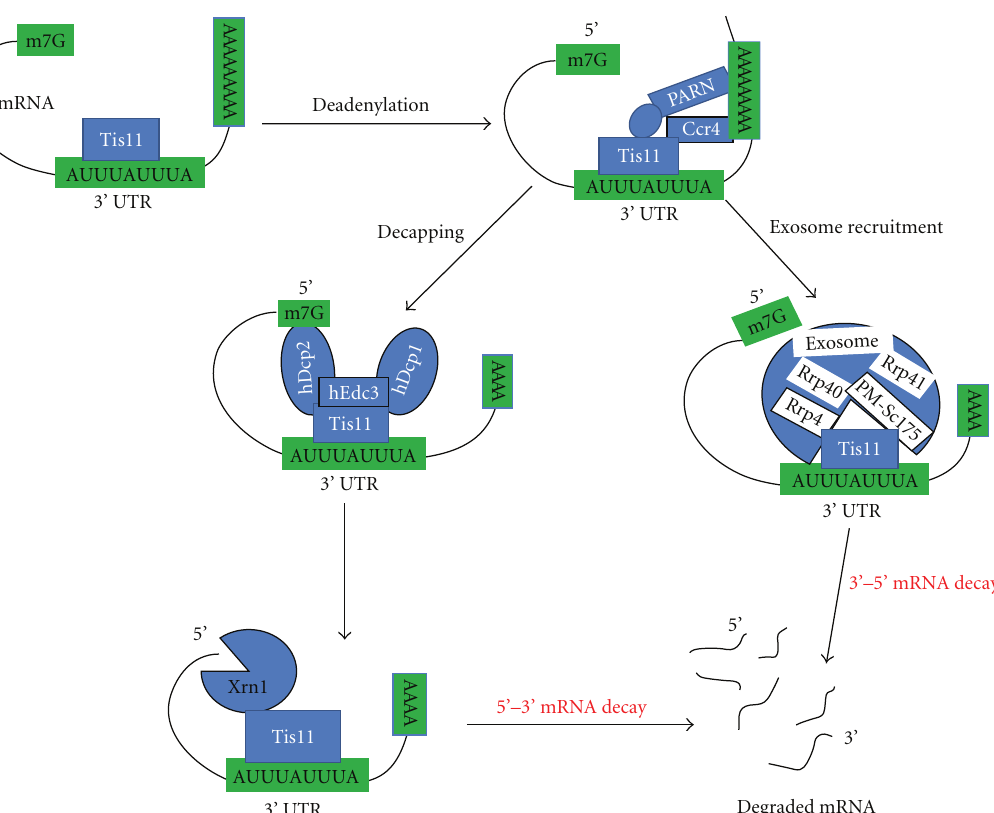
Figure 1: Pathways and major components of ARE-mediated mRNA decay by TIS11 proteins. TIS11 protein binds to the ARE sequence in the 3 (cid:2) UTR and recruits deadenylases either directly (hCcr4) or indirectly (PARN). Deadenylated mRNA can be recruited by the exosome, a multiprotein structure containing proteins such as Rrp4, Rrp40, Rrp41, and PM-Scl75 that form the 3 (cid:2) to 5 (cid:2) exoribonuclease complex. Decapping of mRNA can follow deadenylation mediated by decapping enzymes such as Dcp1 and Dcp2 and degradation of mRNA can then be mediated by the 5 (cid:2) to 3 (cid:2) Xrn1